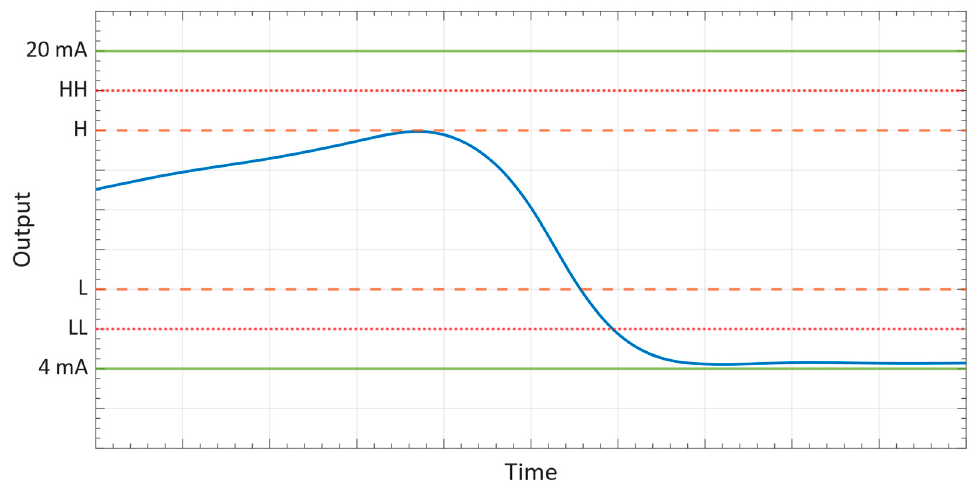
Figure 3. Output range and safety thresholds for a 4–20 mA analog sensor in case of logic solver diagnostics.